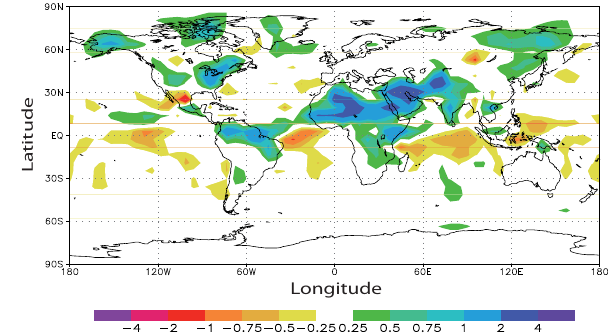
Fig. 19. Simulated difference of summer (JJAS) precipitation (in mm per day) between the mid-Holocene and present-day conditions.